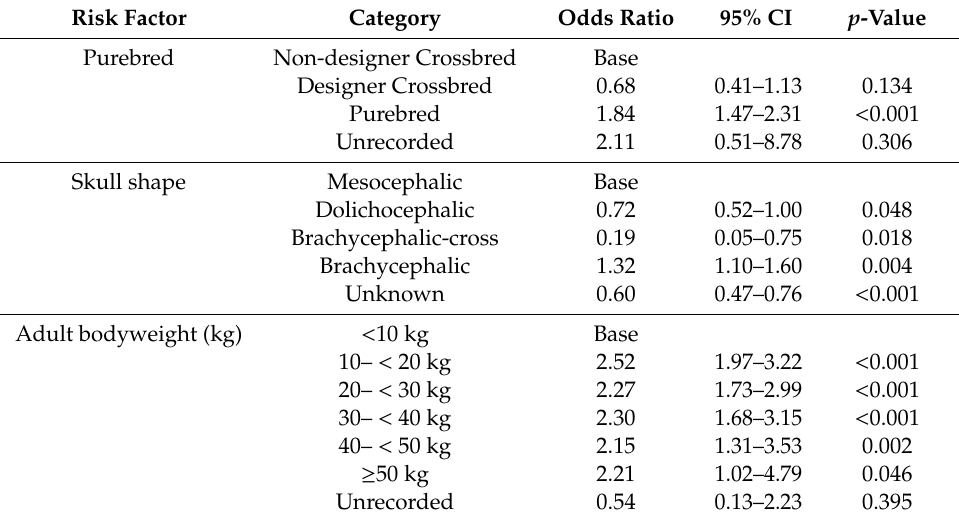
Table A2. Results for variables that individually replaced the breed type variable in the final multivariable logistic regression model (with age, bodyweight relative to breed / sex mean and sex / neuter) to evaluate risk factors associated with exertional heat-related illness in dogs under primary veterinary care in the VetCompass